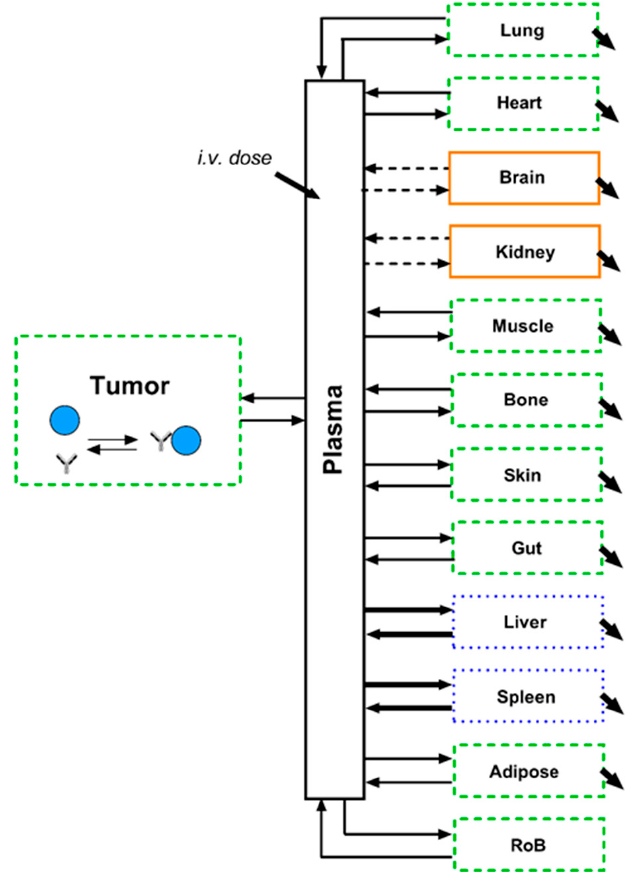
Figure 2. Schematic illustration of the final tumour uptake model linked to the PBPK model: The PBPK model contains three categories of organs, depending on the underlying vascular structure. Black arrows indicate rate constants for antibodies (i.e., distribution, binding, elimination). Blue dotted: organs with discontinuous capillaries and interstitial space assumed highly accessible for antibodies and in quick equilibrium with plasma space (bold arrows). Green dashed: organs with continuous capillaries and interstitial space accessible for antibodies with a distinct uptake and outflow for antibodies. Orange solid: organs with specialised capillaries (e.g., glomerular filter & blood brain barrier) and interstitial space largely non-accessible for antibodies (dashed arrows). Binding of antibodies to cell surface target on tumour cells included in the tumour interstitial compartment.